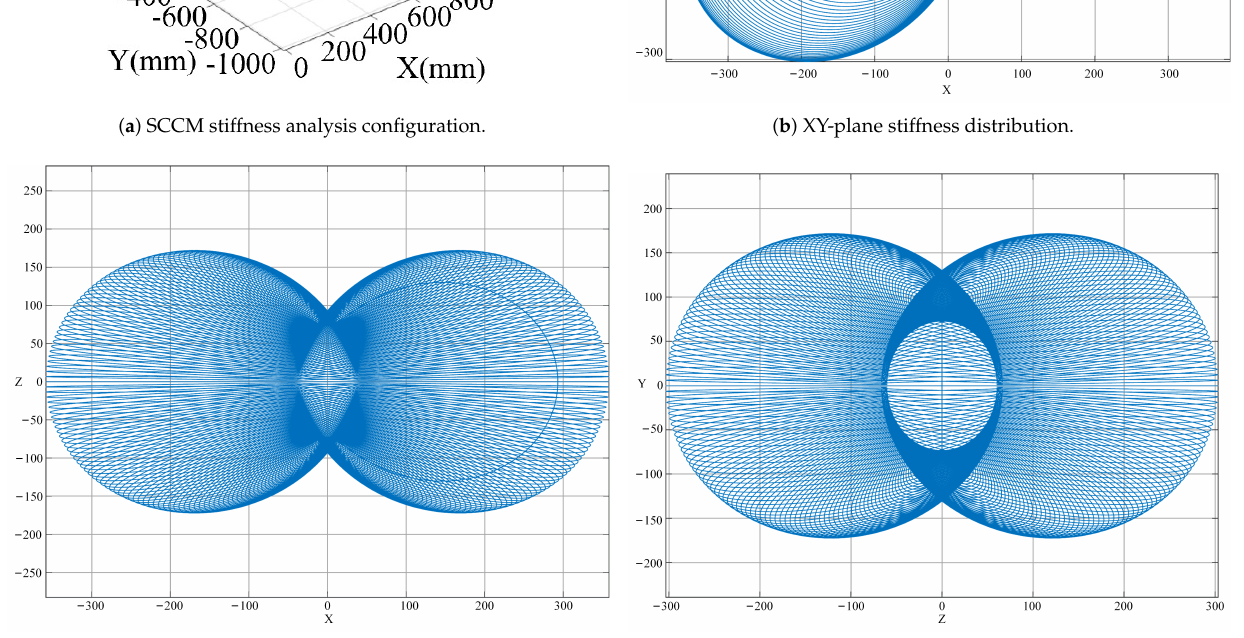
Figure 7. Stiffness